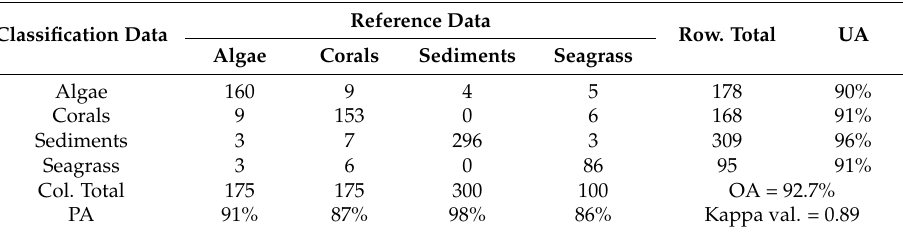
Figure 10. The number of the correct species classified by each classifier for benthic cover mapping. Table 3. The OA and Kappa results of all methods for benthic habitats mapping for the Shiraho area. Figure 9. The benthic cover map of the Shiraho study area resulted from the Quickbird image using the WMV algorithm.